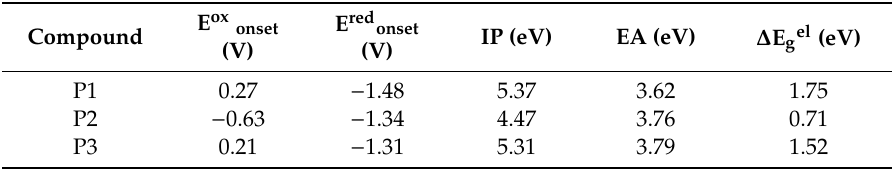
Table 2. Redox properties of polymers. IP—ionization potential, estimated from equation IP [eV] = | e | 5.1 + E ox onset [V]; EA—electron a ffi nity, estimated from equation EA [eV] = | e | 5.1 + E red